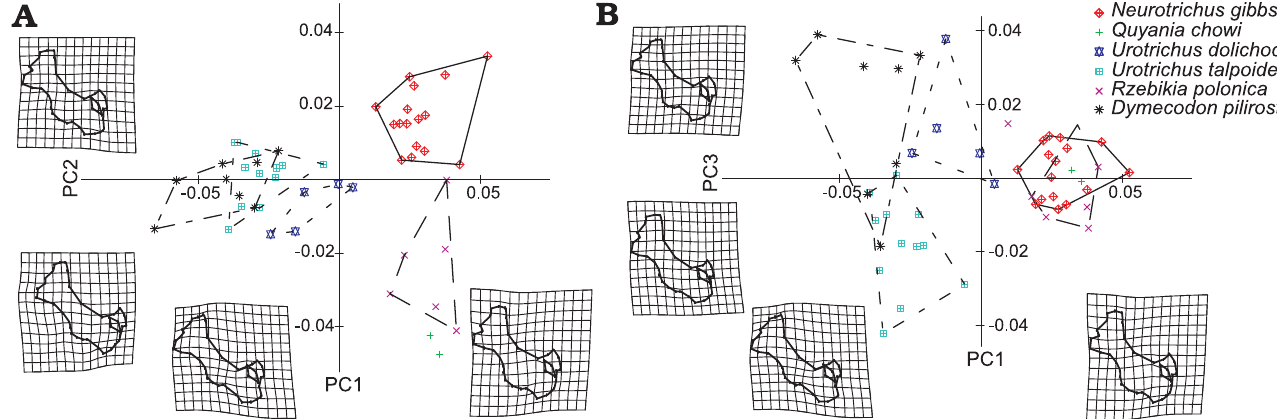
Fig. 3. A . Scatterplot of the first two axes of the bgPCA. Deformation grids refer to axes extremes (positive and negative values). B . Scatterplot of the first and third axes of bgPCA. Deformation grids refer to axes extremes (positive and negative